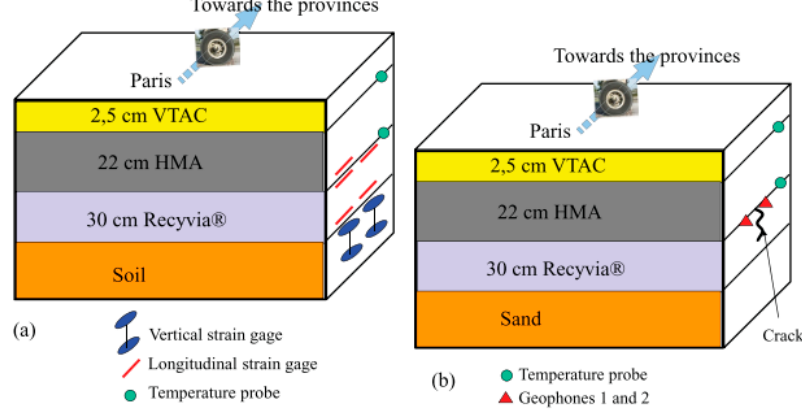
Figure 15. Road structure and sensors layout of the motorway A10 in France. ( a ) Sections PR15 + 700, PR15 + 900, PR16 + 850, and PR17 + 100 and ( b ) section PR16 + 026 (figure is reproduced from Blanc et al. [44]).